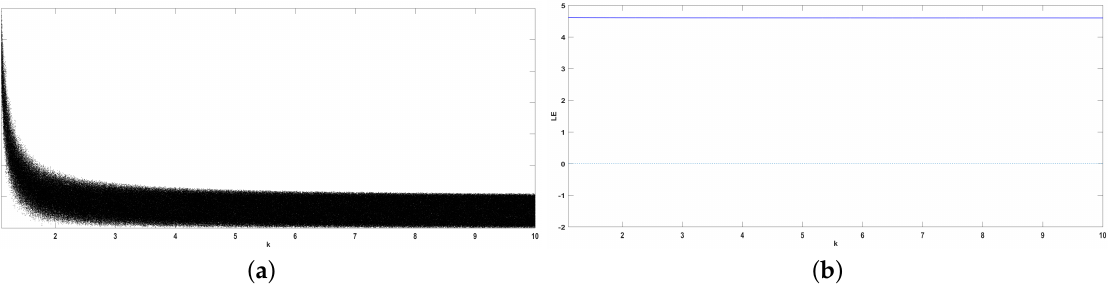
Figure 3. ( a ) Bifurcation diagrams for the map (23) with respect to parameter k , for a = 100, N = 1.